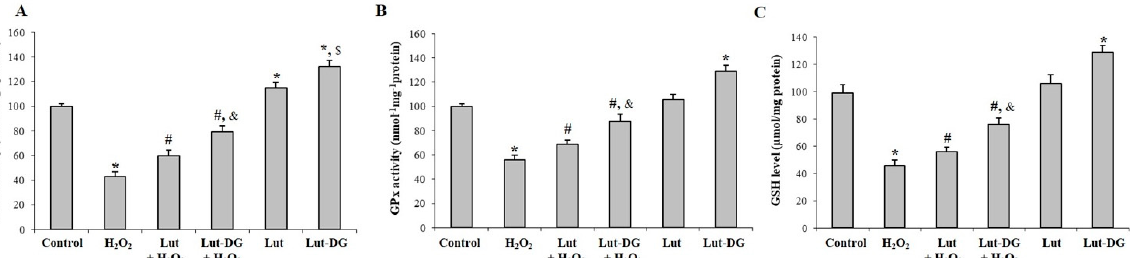
Figure 7. Protective effects of Lut and Lut-DG against oxidative stress occurs through modulation of enzymatic antioxidants ( A ) catalase (CAT) and ( B ) glutathione peroxidase (GPx), and non-enzymatic antioxidant ( C ) glutathione (GSH). ARPE-19 cells were pre-treated with 1 µM of Lut and Lut-DG for 24 h, followed by H 2 O 2 treatment at 400 µM for 1 h. ( A ) CAT and ( B ) GPx activities and ( C ) GSH levels were assessed by kit assays. Graphs represent the mean ± SD values, n = 4; (One-Way ANOVA test), * p ≤ 0.05 vs. control group, # p ≤ 0.05 vs. H 2 O 2 group, & p ≤ 0.05 vs. Lut + H 2 O 2 group and $ p ≤ 0.05 vs. Lut group).